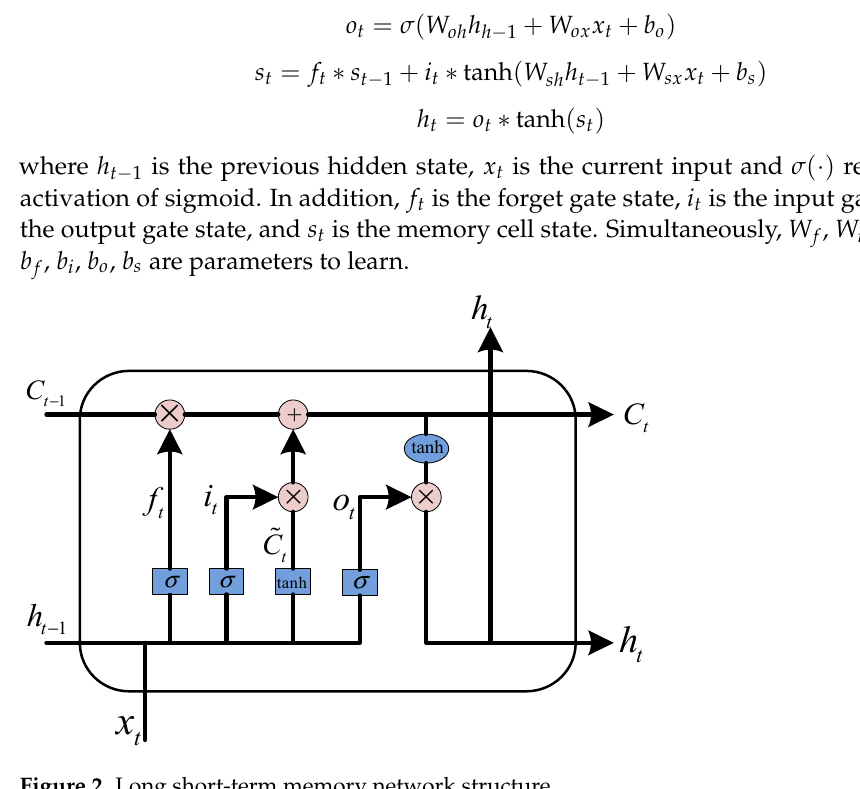
Figure 2. Long short-term memory network structure.